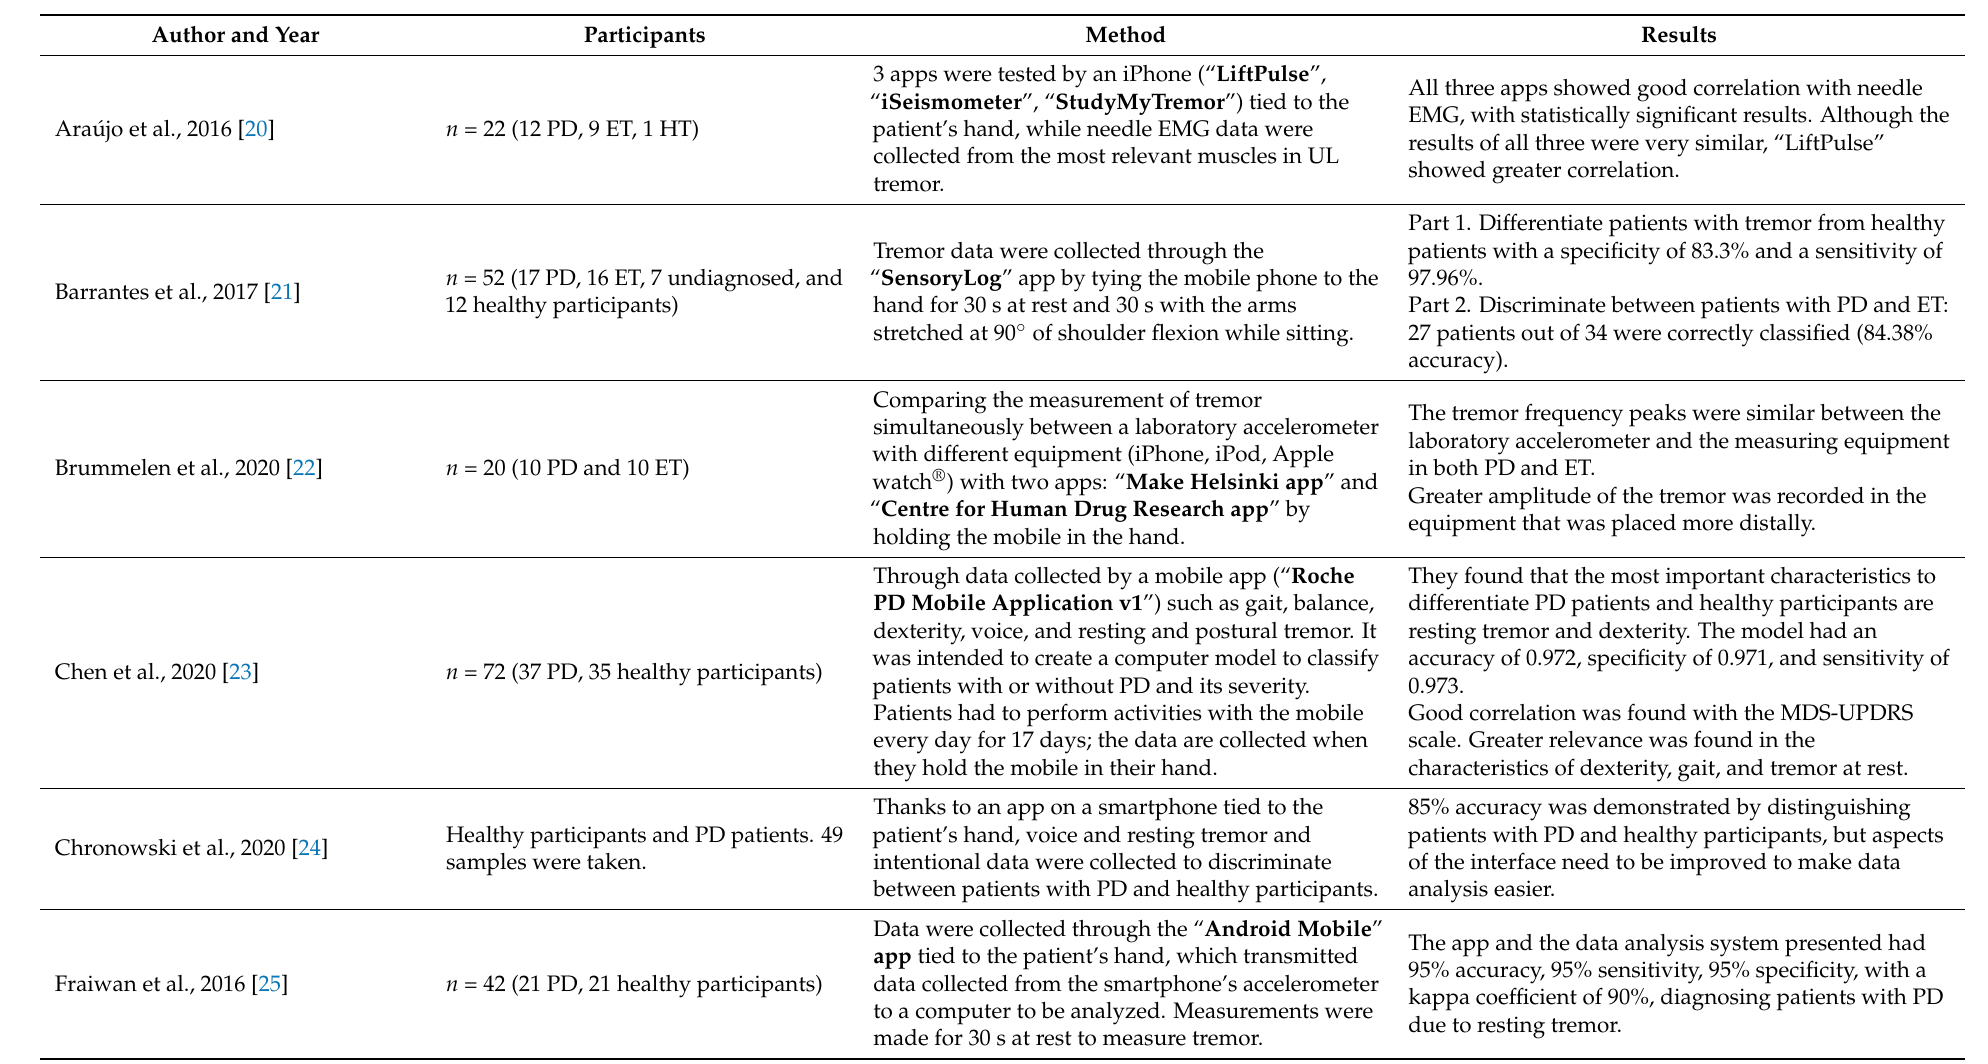
Table 2. Characteristics of the studies included in the